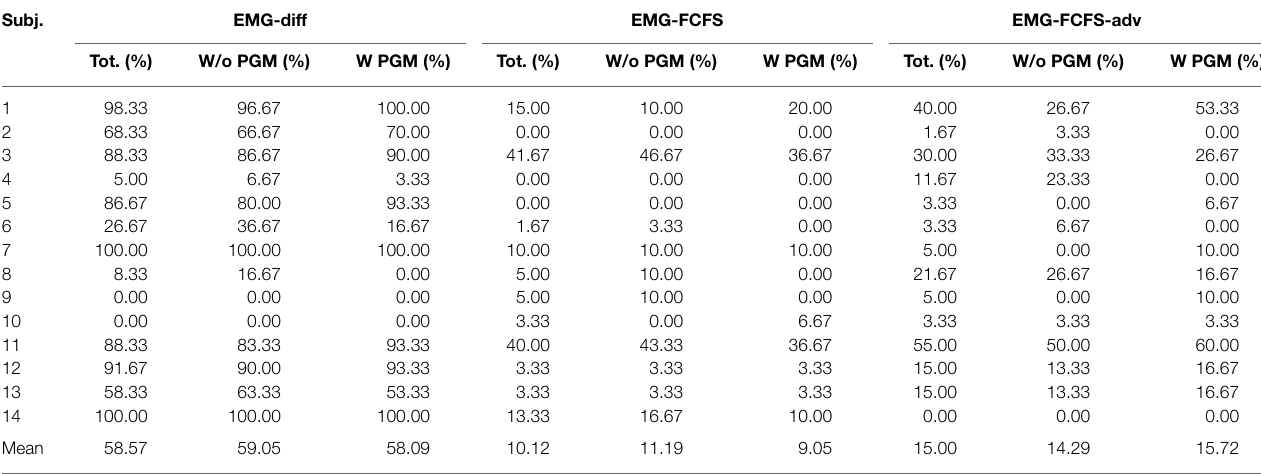
TABLE 1 | Experiment 3 : activation rate with the different algorithms, considering (W PGM) and discarding (W/o PGM) the proportional gain modulation . Subj. EMG-diff EMG-FCFS EMG-FCFS-adv Tot.